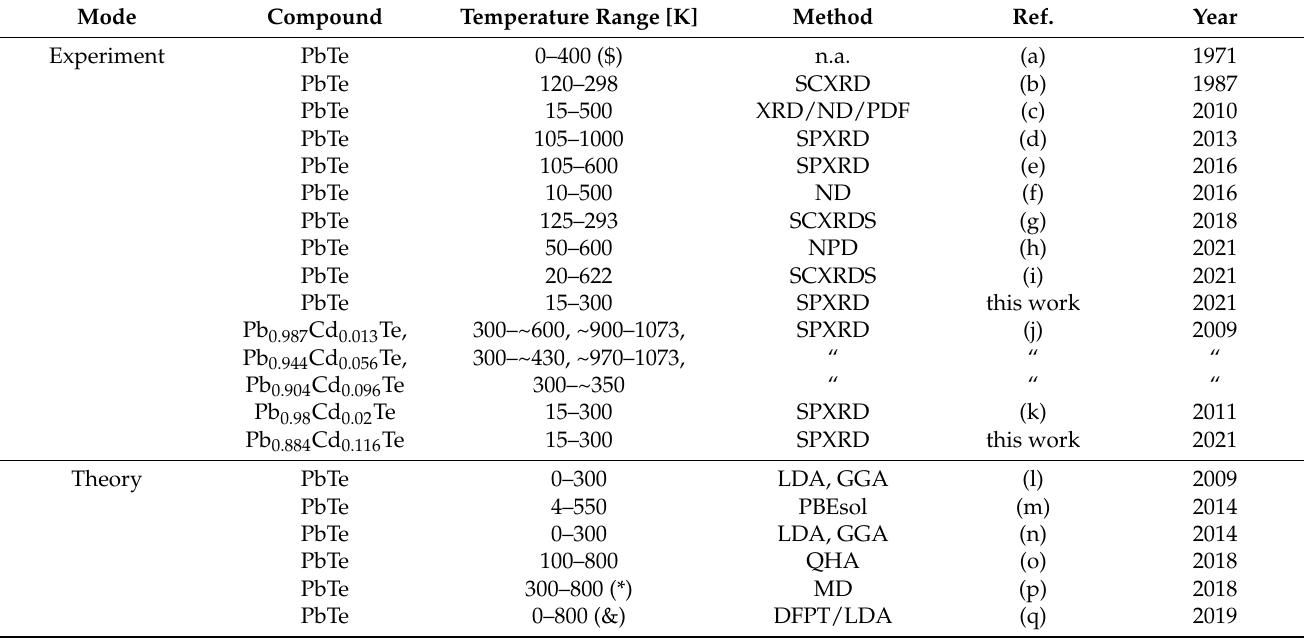
Table 2. Temperature ranges for selected experimental and theoretical studies of the lattice parameter, a ( T ), of PbTe and Pb 1 − x Cd x Te ( x = 0.013, 0.020, 0.056, 0.096, 0.116). In the case of experimental studies, the ranges refer to the lower and upper limit of the experiment.